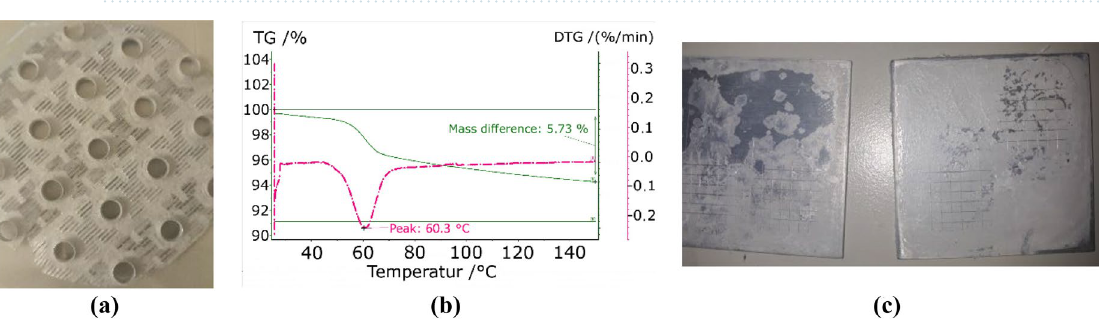
Figure 8. CaCl 2 coating with HEC: ( a ) fin, ( b ) TGA, ( c ) cross-cut test without (left) and with HEC (right).